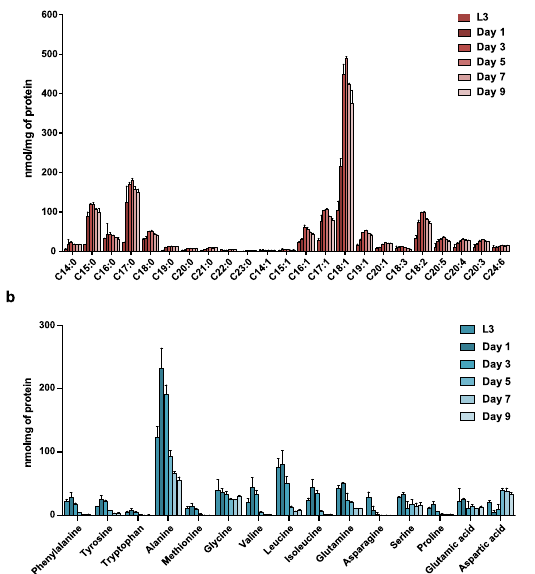
Figure 6. Metabolite changes in glp-4 ( bn2 ) mutant worms during life history. ( a ) FAs were measured in different ages of glp-4 ( bn2 ) mutants, including the larval stage 3 (L3), the reproductive phase (day 1–5 of adulthood), and post-reproductive phase (day 7–9). Most FA species increased during adult life, and slightly decreased in the post-reproductive phase. C18:3 reached its highest abundance at younger stage then decreased with age. ( b ) Most AA species reached a peak at L3 and day 1 of adulthood and subsequently decreased with age in glp-4 ( bn2 ) mutant worms. In the glp-4 ( bn2 ) worms aspartic acid accumulated and glycine remained more or less equal, similar to the changes observed in the wild type N2 worms grown under the same culture conditions (25 °C and without 5FU). See also Supplementary Fig.